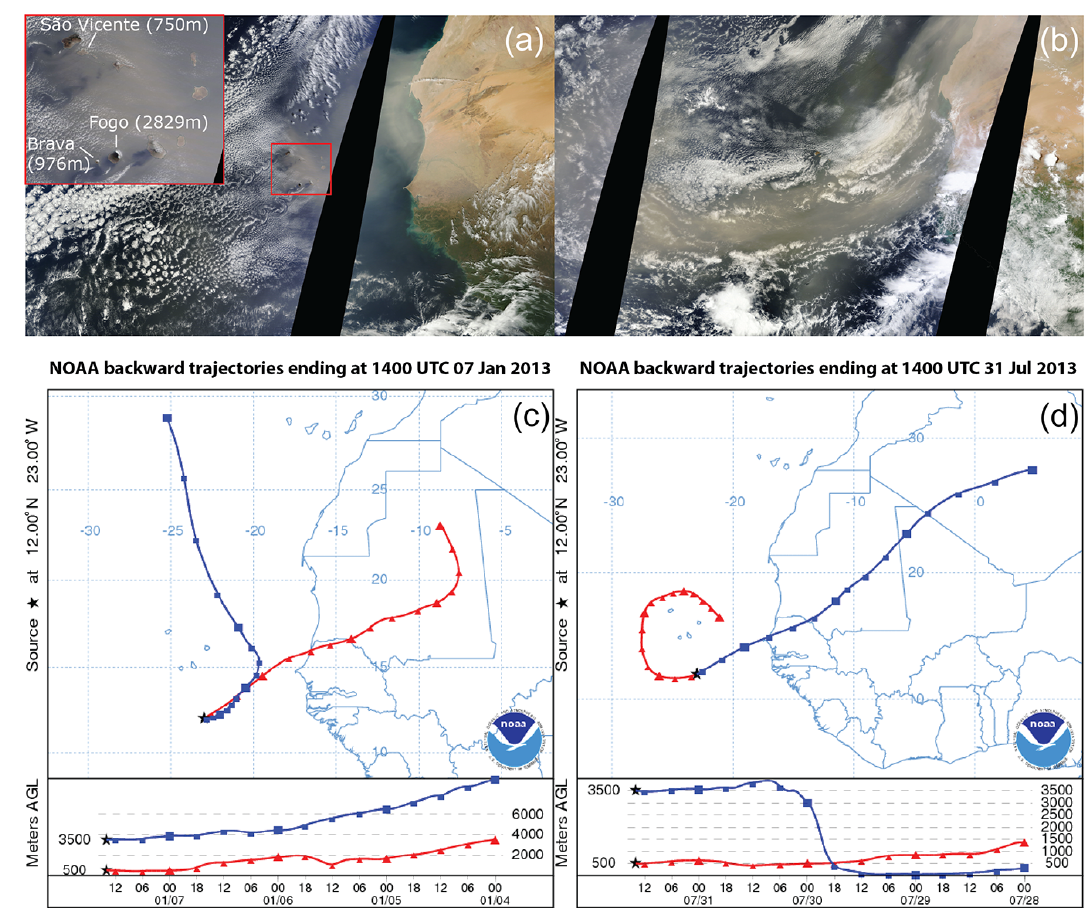
Figure 9. (a) Satellite images of typical winter dust transport, with a close-up of the Cabo Verde islands (7 January 2013) and (b) typical summer dust transport (31 July 2013) over the Cabo Verde islands, at relatively low and high altitudes, respectively. Images from NASA Worldview, MODIS Terra satellite. Black areas are artifacts from satellite passage. (c, d) Concurrent 4-day backward trajectories of air parcels from station M1 (star), at 500m (red) and 3500m (blue) AGL, showing trajectory maps (top) and elevation profiles (bottom). (c) Ending at 7 January 2013, and (d) ending at 31 July